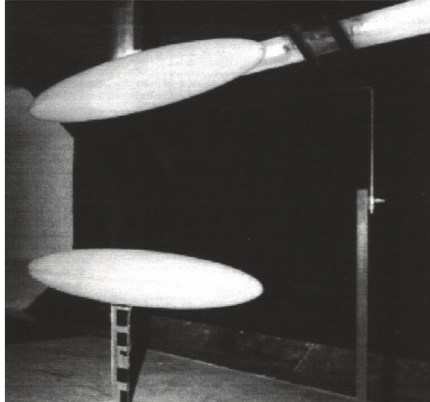
Figure 6: Wind tunnel test of the twin spheroids